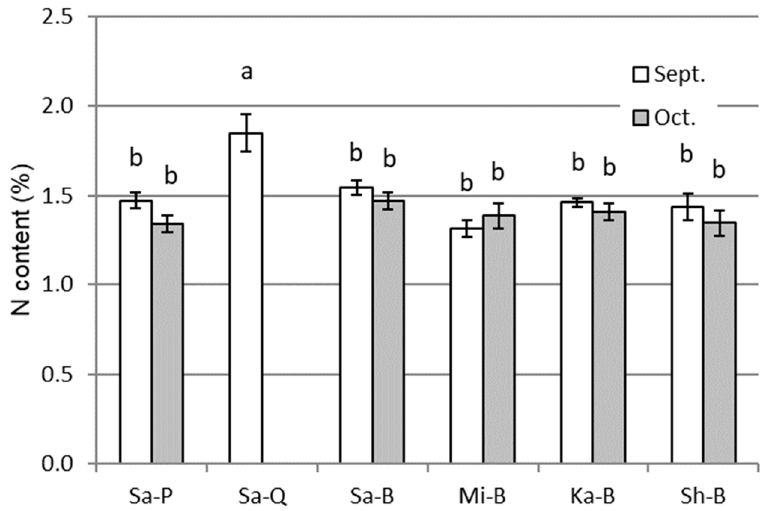
Figure 2. Nitrogen contents of the aboveground parts of different sweet potato cultivars of different origins at two measurement time points, September and October, in the course of cultivation in an experimental field. All other details are the same as in Figure 1.